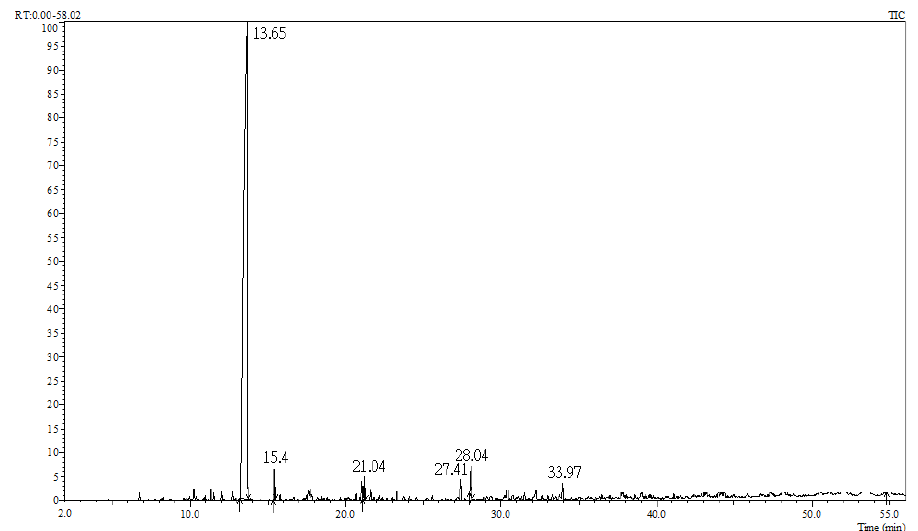
Figure 2. Gas chromatogram of C. osmophloeum ct. linalool leaf oil. Table 1. Constituents of C. osmophloeum ct. linalool leaf oil.